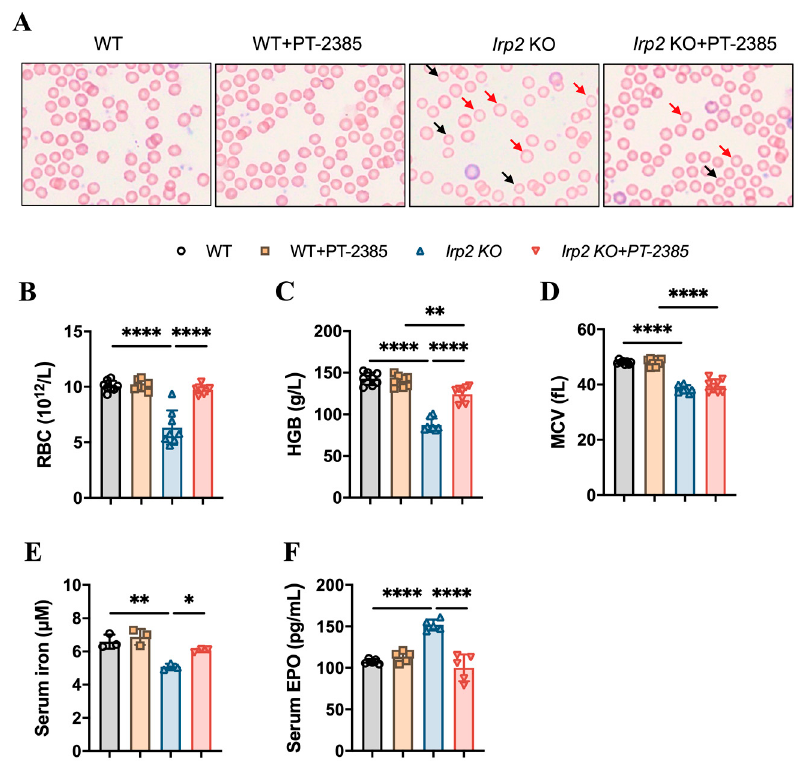
Figure 1. Hif2 inhibition by PT − 2385 ameliorates anemia in Irp2 KO mice. Six-month-old mice were divided into four groups: WT (DMSO as vehicle), WT+PT − 2385 (0.4 mg/kg i.p. qod), Irp2 KO (vehicle), and Irp2 KO+PT − 2385. ( A ) Improved hypochromic anemia by PT − 2385 in Irp2 KO mice on peripheral smear determined by Wright-Giemsa staining. Red arrows point to hypochromic red blood cells, black arrows point to small red blood cells. Routine blood examinations: ( B ) number of red blood cells (RBCs), ( C ) hemoglobin (HGB) concentration, and ( D ) mean corpuscular volume (MCV). ( E ) Serum iron content detected by ferrozine assays. ( F ) Serum EPO levels detected by enzyme-linked immunosorbent assays (ELISA). ( E ) n = 3, ( B – D , F ) n = 5–8. Results are shown as mean ± SD. One-way ANOVA was used for significance. * p < 0.05, ** p < 0.01, **** p < 0.0001.